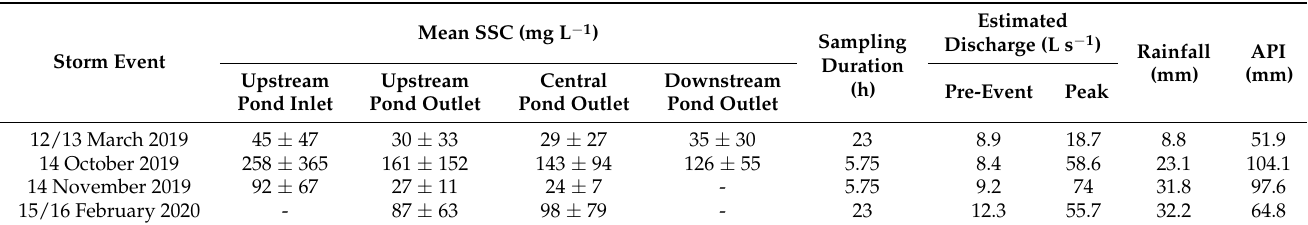
Table 2. Mean ( ± SD) SSC (mg L − 1 ) for each pond monitoring site during four storm events, estimated discharge (L s − 1 ) prior to the event and at its peak, and the sampling duration (hours). Rainfall (mm) is the total event precipitation and Antecedent Precipitation Index (API) (mm) is given for the day prior to each event.